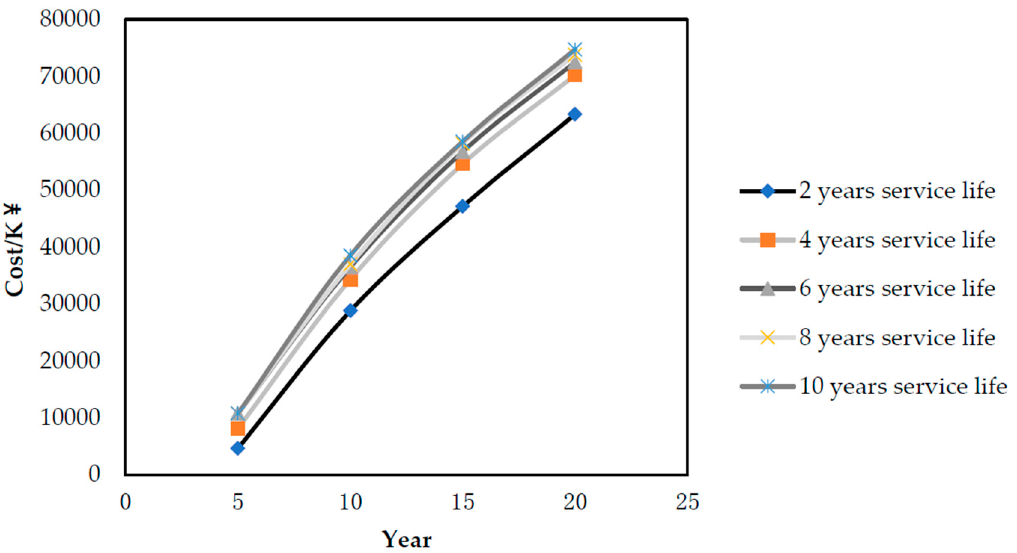
Figure 6. NPV calculation results under the different membrane life cycles.